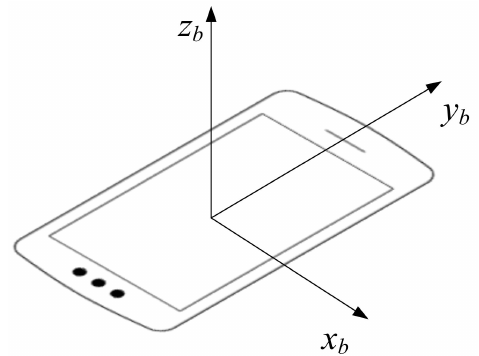
Figure 1. The body coordinate system of